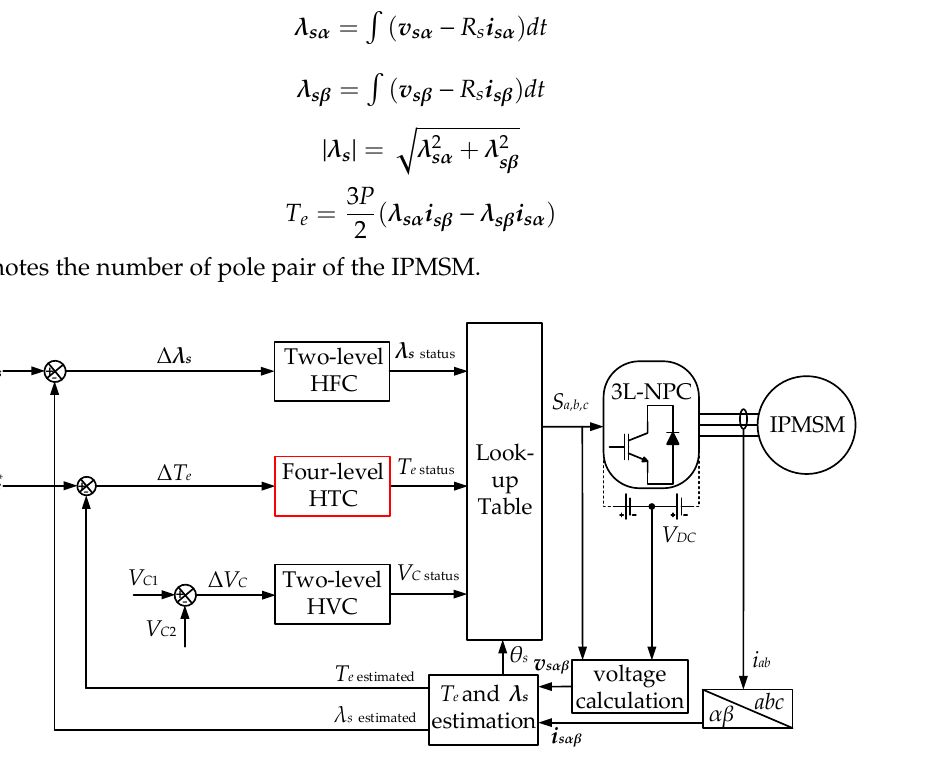
Figure 2. Schematic block diagram of 3L- direct torque control (DTC) for IPMSM.